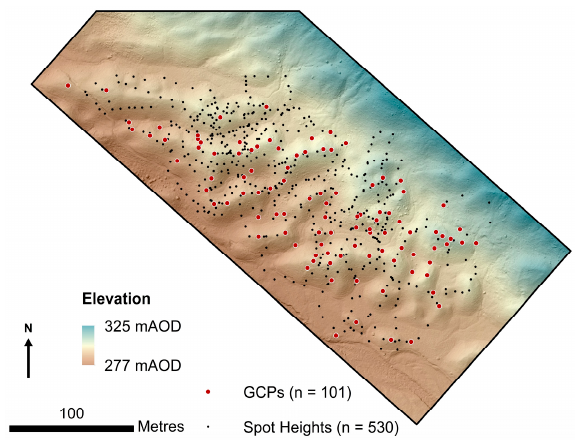
Figure 2. A digital surface model (DSM) of the Ennerdale moraines with the positions of ground control points (GCPs) (101 GCPs) and spot heights indicated (530 spot heights). The trimmed survey area displayed here is 0.071 km 2 .